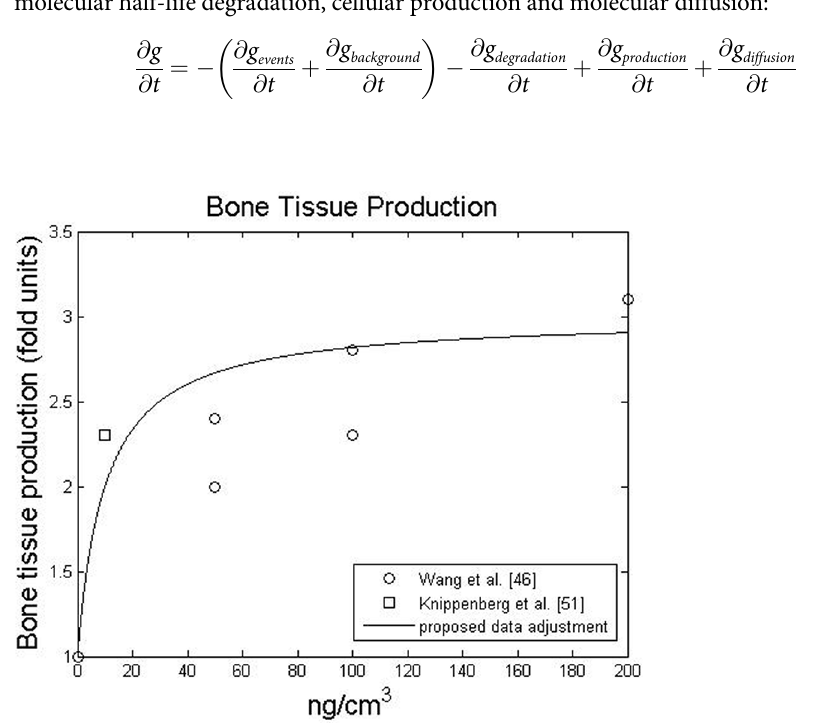
Fig 4. Influence of BMP-2 on bone tissue production. Bone tissue production is expressed as a fold increase relative to bone tissue production without